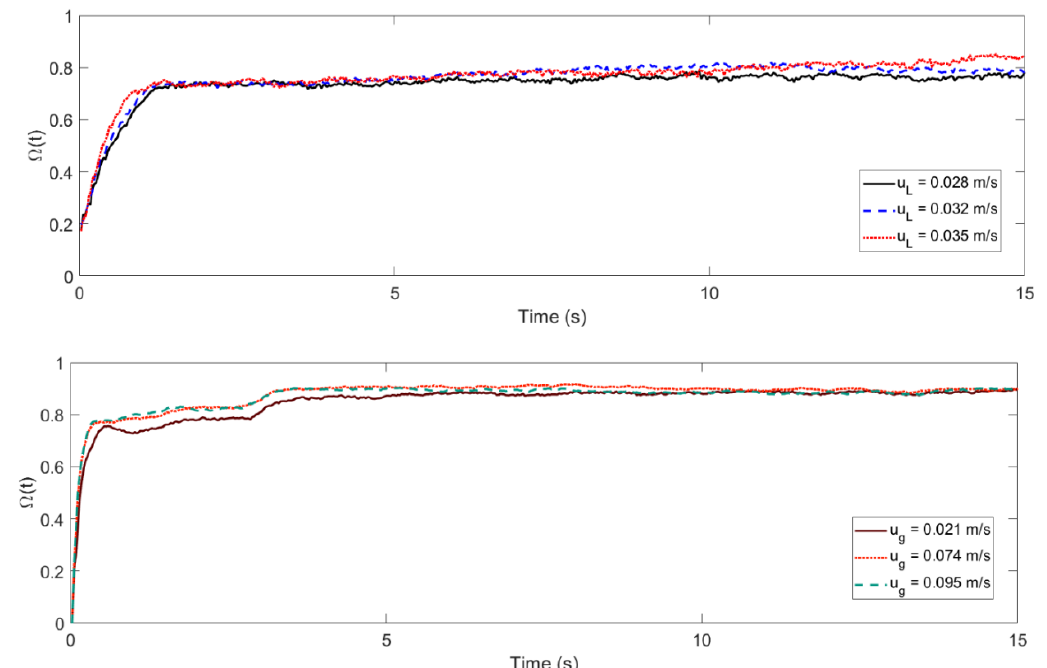
Figure 4. Normalized Shannon entropy as a function of the manifold time for the LSFB ( above ) and the GLSFB ( below ), shown for different fluid superficial velocities.